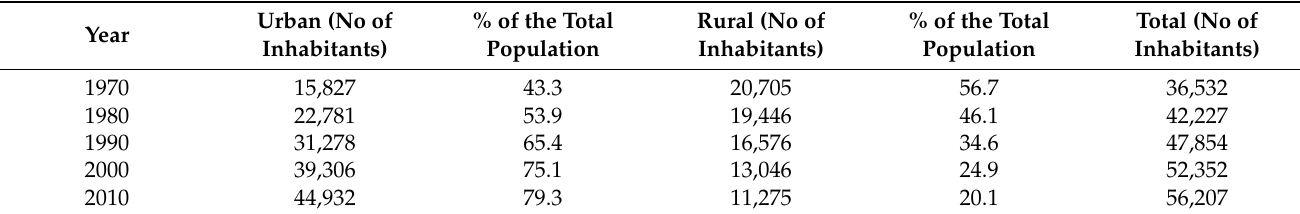
Table 1. Changes in Irati’s urban/rural population in decade time-steps (official census